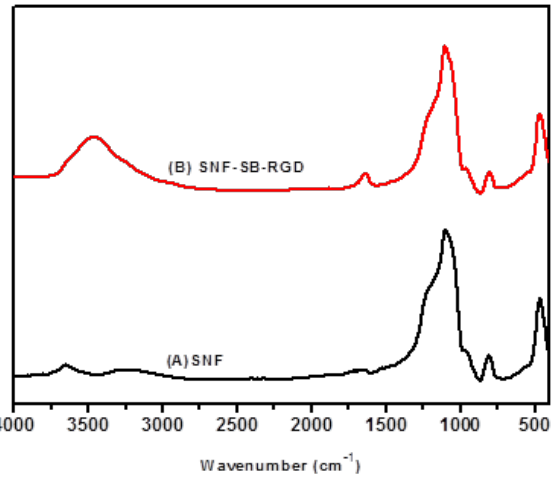
Figure 3. FTIR spectra of ( A ) SNF and ( B ) SNF-SB-RGD.